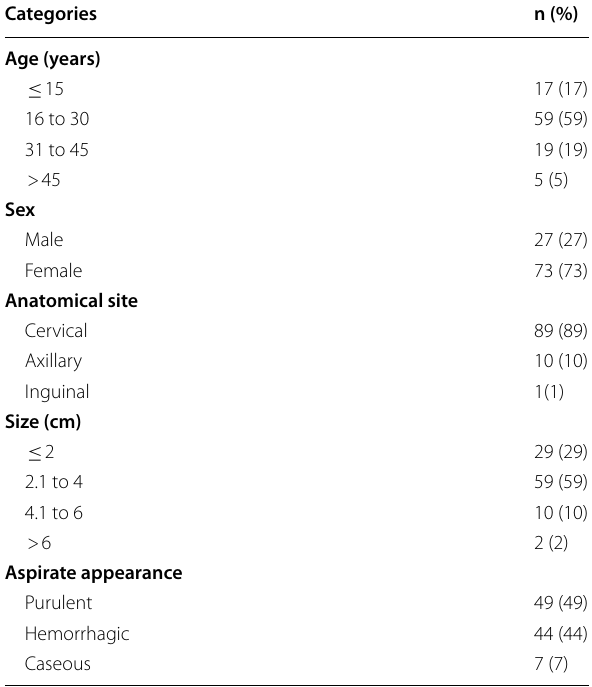
Table 1 Distribution of demographic and clinical characteristics